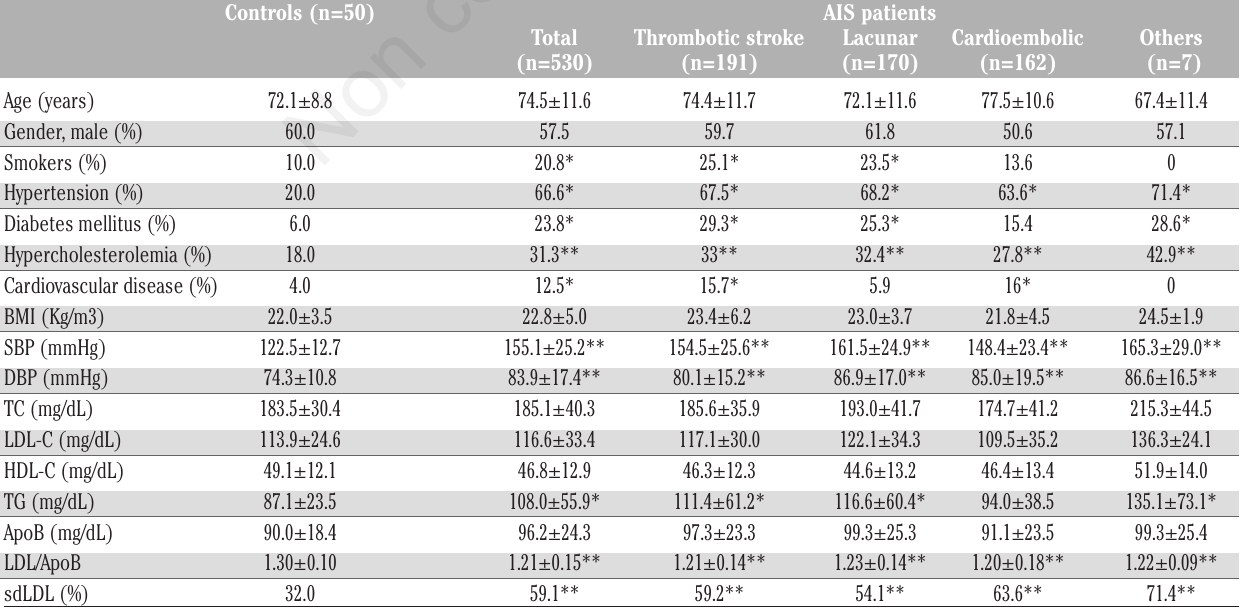
Table 1. Biochemical characteristics of controls and acute ischemic stroke patients with various types of stroke. Controls